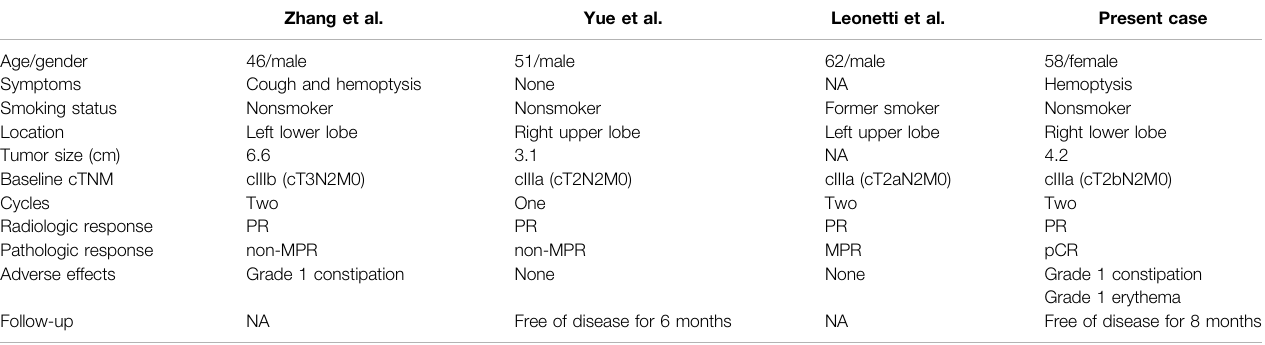
TABLE 1 | Summary of all cases of ALK-positive patient receiving neoadjuvant alectinib therapy. Zhang et al. Yue et